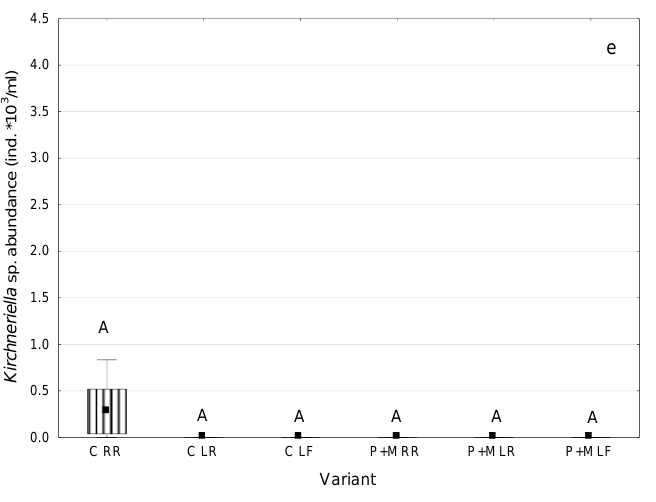
Figure 1. Abundance of bacterial cells ( a ), Chlorella sp. ( b ), flagellate green algae ( c ), Navicula sp. ( d ), and Kirchneriella sp. ( e ) in controls (C) and variants with S. polyrhiza (P + M) containing MCs after nine days of incubation (mean ± SD; n = 3). Uppercase letters (A, B, C, D) indicate statistically significant differences among experimental variants (ANOVA, Tukey’s test, p < 0.05). C—controls containing MCs, but without plants; P + M—experimental variants with MCs, plants, and associated microorganisms. Biodegradation of MC-RR, MC-LR, and MC-LF and the retention times of degradation